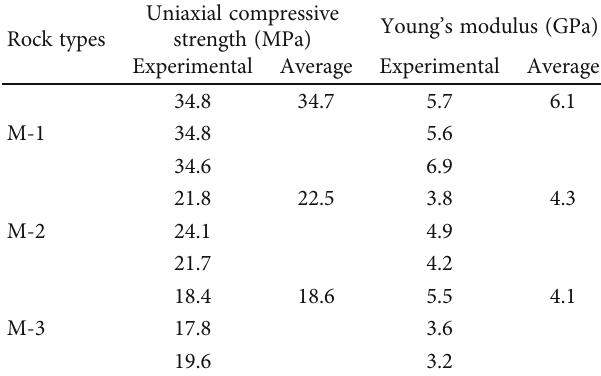
Table 2: Mechanical properties of mudstone. Rock